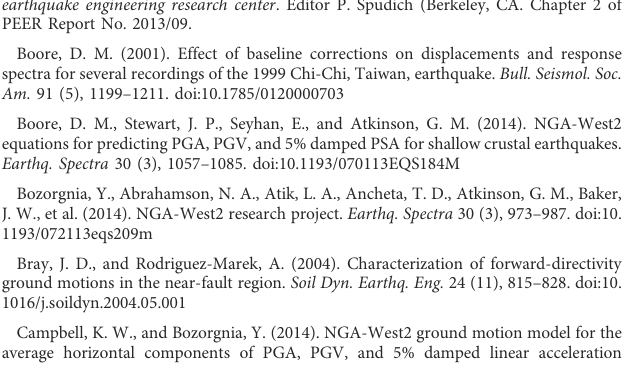
SUPPLEMENTARY FIGURE S1 Spatial distribution of residuals for various intensity measures, around the causative fault (rectangle). (A) PGA, PGV and short-period ground motion less than 1.0 s. (B) long-period ground motion above 1.0 s. SUPPLEMENTARY FIGURE S2 Comparison of noise level of MEMS records observed during the Ms 5.2 aftershock with the Ms 6.9 mainshock by the station C0029. SUPPLEMENTARY APPENDIX S1 Station information and ground motion parameters of 140 strong motion recordings observed in the MS6.9 Menyuan